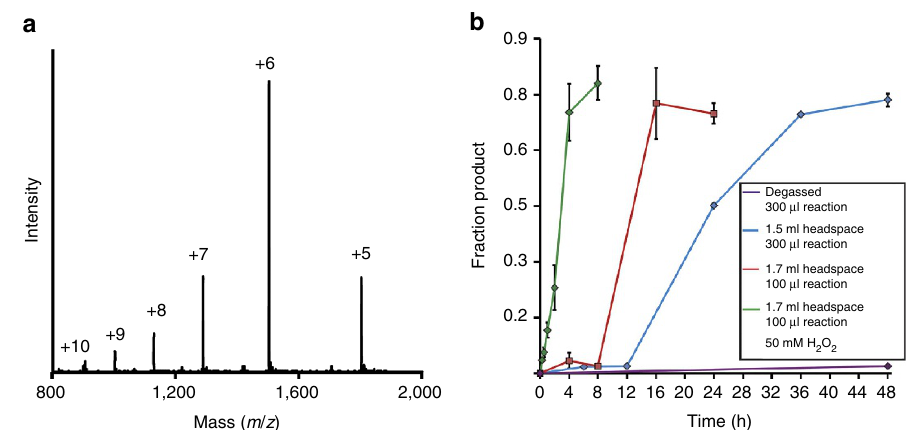
Figure 2 | N–O bond cleavage in the native chemical ligation product KAK Ub(aux) I. ( a ) ESI-MS spectrum of the final ligation product of ubiquitin(1–75)- a - thioester with KAK aux I. Calculated for KAK Ub(aux) I, 9,081.1Da. Observed KAK Ub I, 9,004.8 ± 2.7Da. ( b ) Time-course of N–O bond cleavage and KAK Ub I formation from the auxiliary-containing test substrate KAK Ub(aux) I in a buffer consisting of 200mM MPAA, 100mM NaH 2 PO 4 at pH 7.3 under the indicated conditions. Error bars represent the s.d. from three independent measurements.